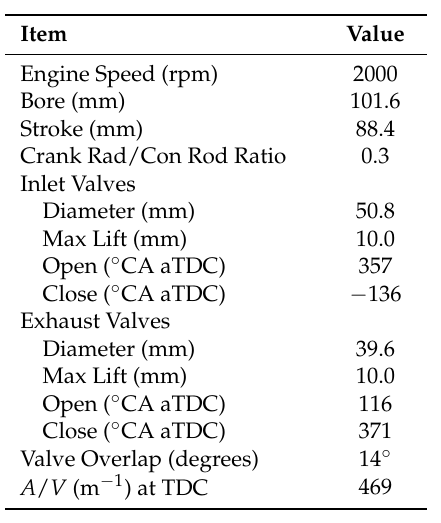
Table 1. Engine Specifications.